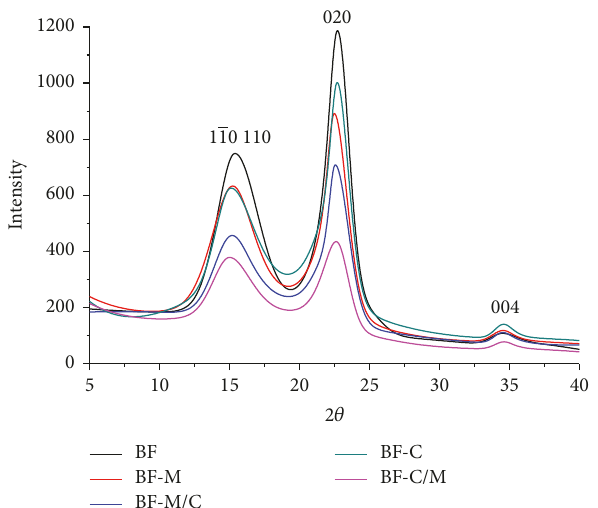
Figure 8: XRD diffractograms of BF samples.